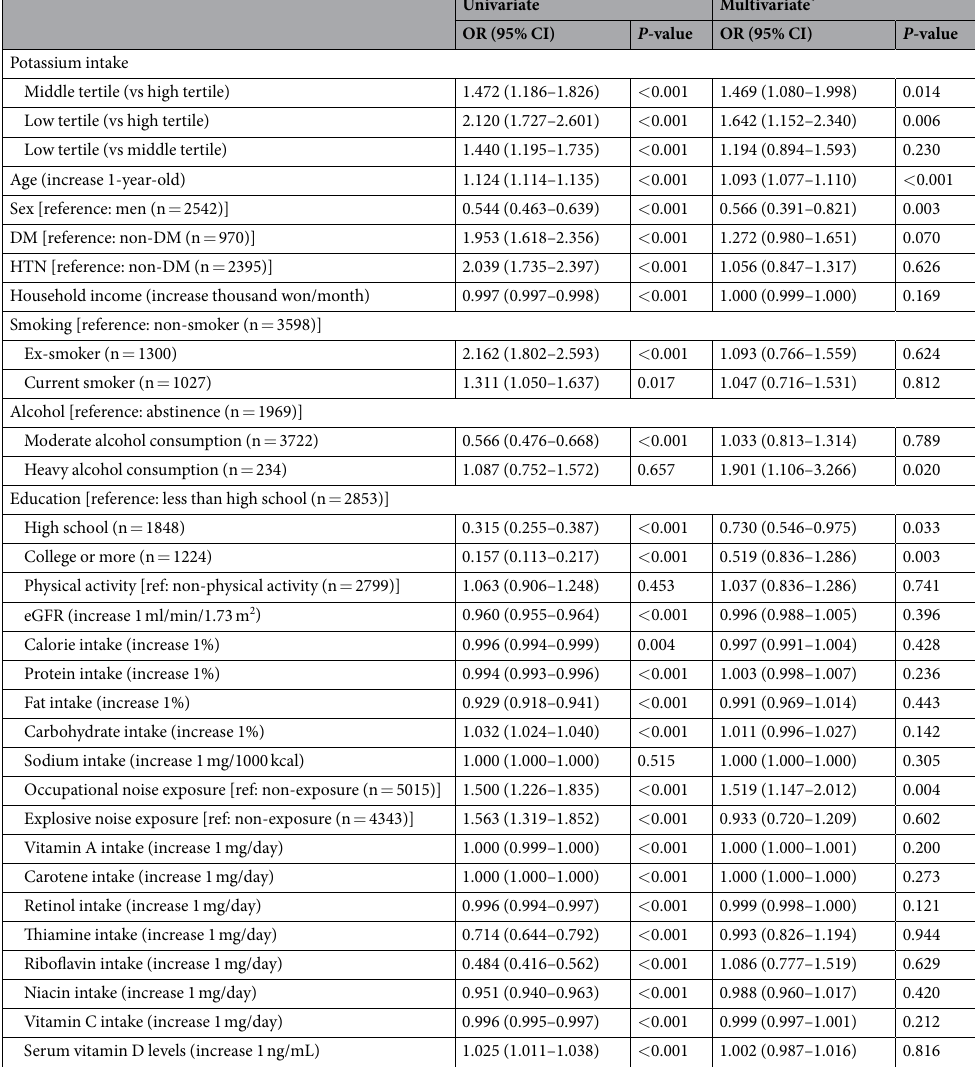
Table 4. Logistic regression analyses of hearing loss according to potassium intake levels. * Multivariate analysis for hearing loss was performed using potassium intake tertiles, age, sex, DM, HTN, household income, smoking habits, alcohol intake, education level, physical activity, eGFR, calorie intake, protein intake, fat intake, carbohydrate intake, sodium intake, occupational noise, explosive noise exposure, vitamin A intake, carotene intake, retinol intake, thiamine intake, riboflavin intake, niacin intake, vitamin C intake, and serum vitamin D levels. Abbreviations: OR, odds ratio; CI, confidence interval; DM, diabetes mellitus; HTN, hypertension; eGFR, estimated glomerular filtration